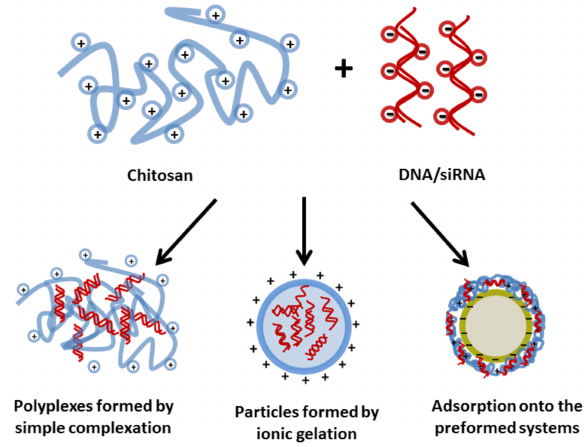
Figure 3. Preparation of chitosan-based DNA/siRNA nanoparticles following different